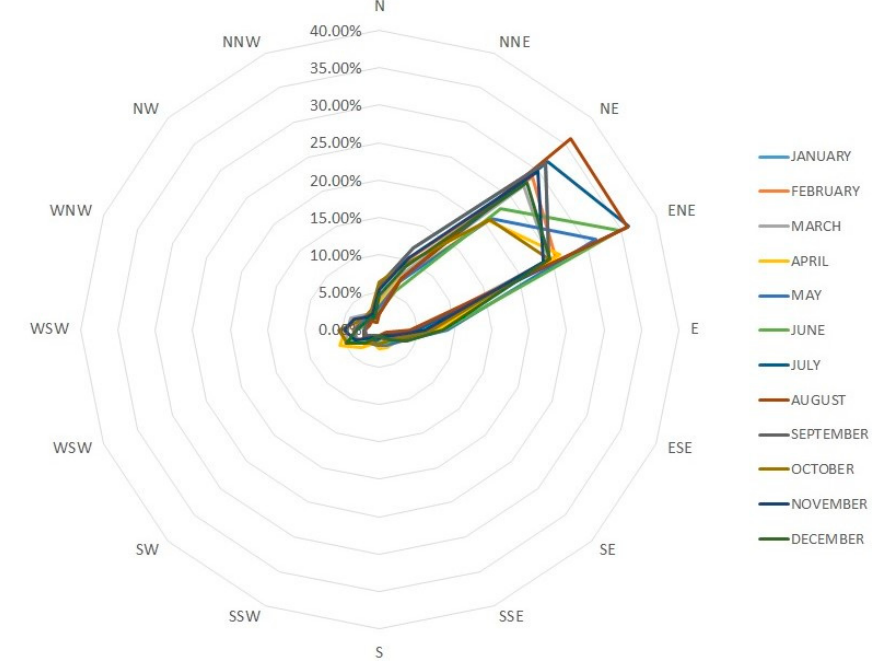
Figure 3. Direction of provenance of the winds recorded by the buoy (2009–2020 period).